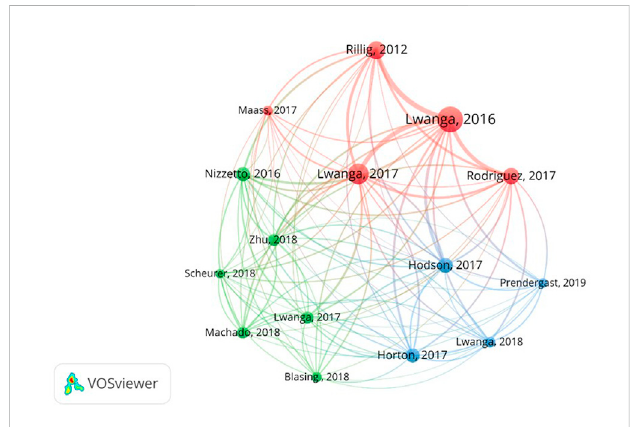
FIGURE 1 Co-citation map of studies published until December 2021 focusing on the interactions between microplastics and earthworms. The size of the nodes indicates the frequency of occurrence, and the thickness of the lines between the nodes indicates the strength of the association. Three main clusters were